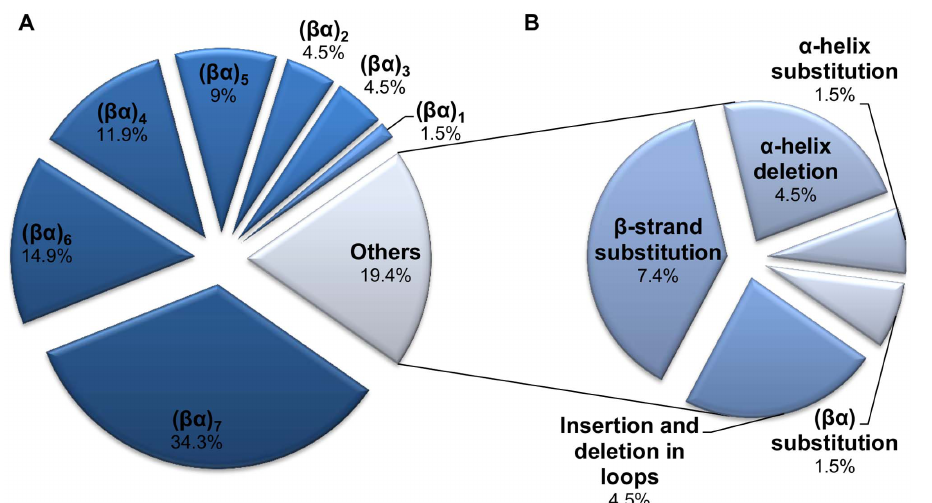
Figure 2. Subdomain distribution of 67 splice variants found in the ( ba ) 8 barrel proteins from the human genome. The different ( ba ) 8 barrel subdomains present in the splice variants are illustrated in a). The typical secondary-structure composition of the canonical ( ba ) 8 barrel consists of eight repeats of ba modules. The secondary-structure composition of different ( ba ) 8 barrel subdomains is described in A. The number of splice variants for each subdomain category is as follows: ( ba ) 1 =1, ( ba ) 2 =3, ( ba ) 3 =3, ( ba ) 4 =8, ( ba ) 5 =6, ( ba ) 6 =10, ( ba ) 7 =23, others =13. The subgroup of the 13 splice variants that cause structural modifications to the ( ba ) 8 barrel proteins without altering their overall fold structure are illustrated in B. The number of splice variants for each category is as follows: b -strand substitution =5, a -helix deletion =3, insertion and deletion in loops =3, ( ba ) substitution =1, a -helix substitution =1. All the illustrated data were taken from Table S5.